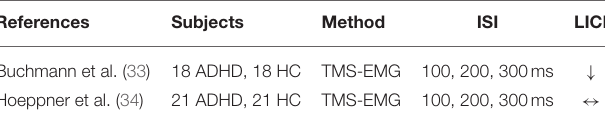
TABLE 1 | LICI in patients with ADHD. TABLE 2 | LICI in patients with bipolar